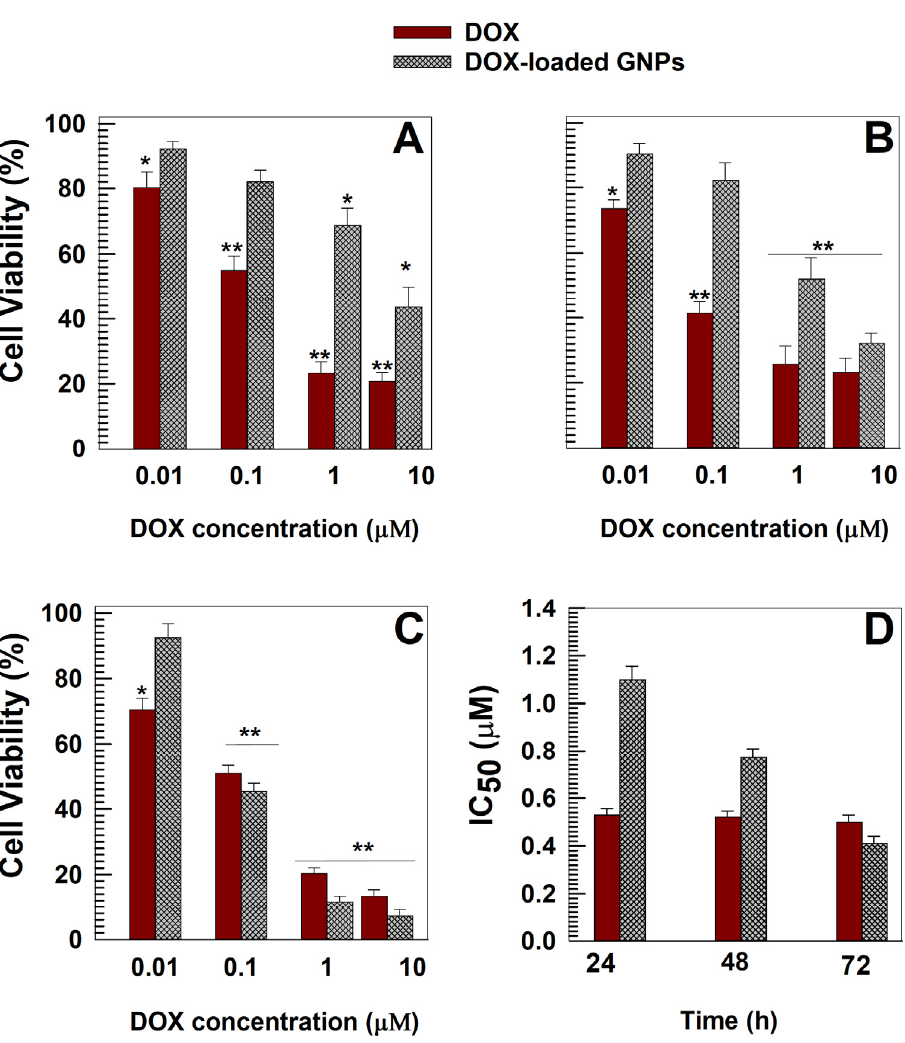
Figure 5. In vitro dose-dependent cytotoxicity of DOX and DOX-loaded GNPs evaluated by MTT testing on MCF-7 cells after ( A ) 24, ( B ) 48 and ( C ) 72 h of incubation. ( D ) Evaluation of the IC 50 values ( µ M) of DOX and DOX-loaded GNPs Results are the mean of three different experiments ± standard deviation. * p < 0.05, ** p < 0.001 with respect to the untreated cells.